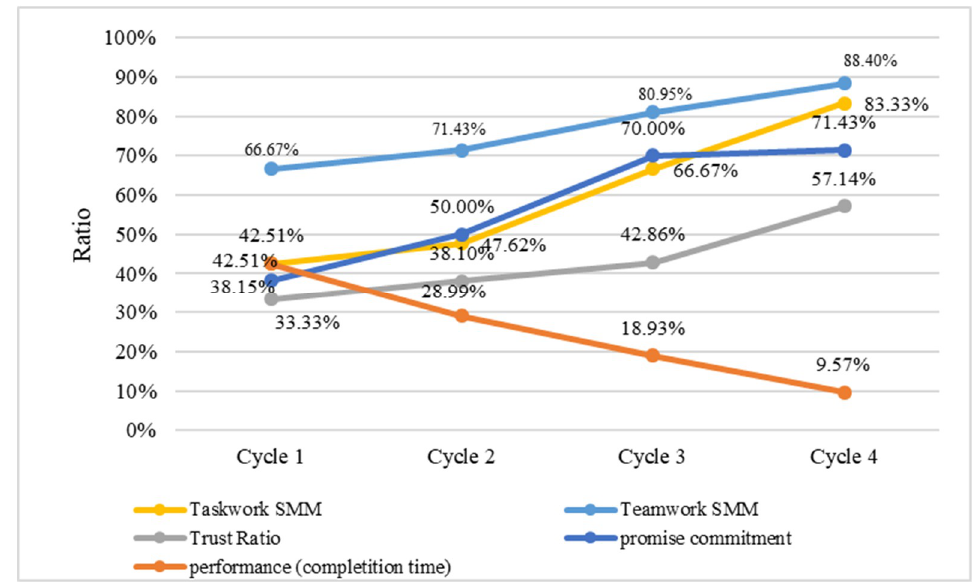
Figure 8. Progressive ratios Taskwork SMM, Teamwork SMM, trust in IVA’s decision, human’s commitment, and overall tam performance over four consecutive cycles.